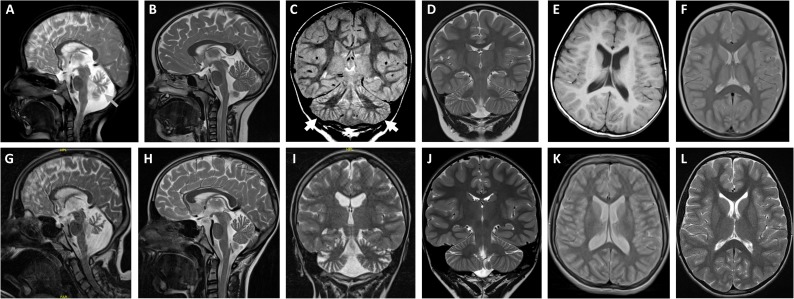
Brain imaging of patient 1 revealed cerebellar atrophy.(A, C and E) Selected brain MRI scans of patient 1 at the age of 3 years in comparison to age-matched normal scans (B, D and F; all T2-weighted). T2-weighted sagittal section (A) and coronar section (C) show moderate cerebellar atrophy including the vermis and hemispheres (indicated by arrows). (E) T1-weighted transversal section showing no supratentorial abnormalities. (G, I and K) Selected MRI scans of patient 1 at the age of 14 years in comparison to age-matched normal scans (H, J and L; all T2-weighted). T2-weighted sagittal section (G) and coronar section (I) demonstrate severe cerebellar atrophy. (K) Mild ventricular enlargement is observed on T2-weighted transversal section.